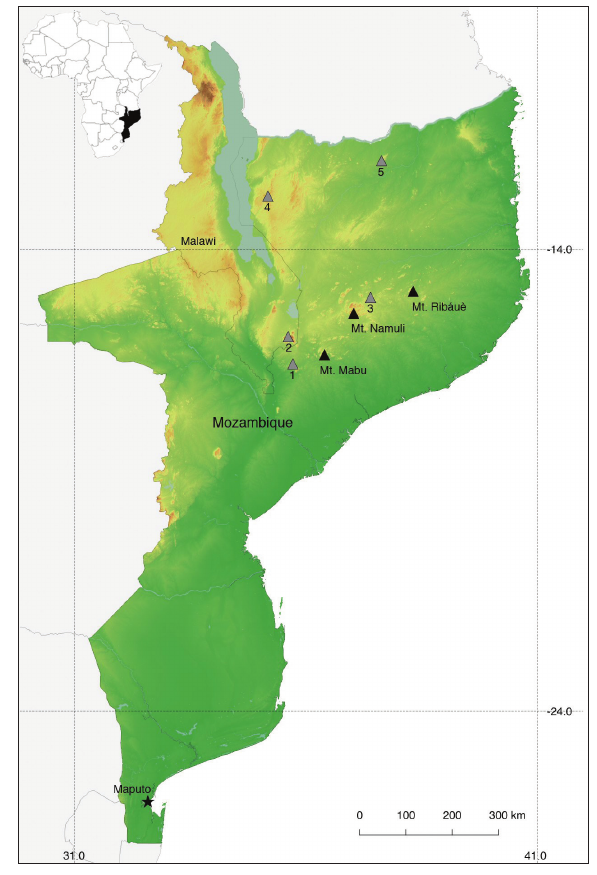
Figure 1. Map of localities surveyed in northern Mozambique. Black triangles indicate the mountains sampled during this study and grey triangles show other areas previously sampled in northern Mozambique and southern Malawi. Numbers indicate the following localities: ( 1 ) Mt. Chiperone, ( 2 ) Mt.